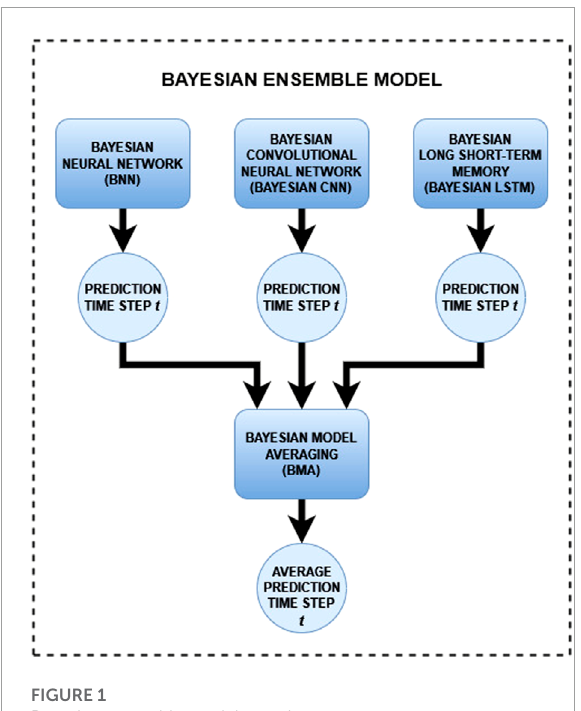
FIGURE 1 Bayesian ensemble model